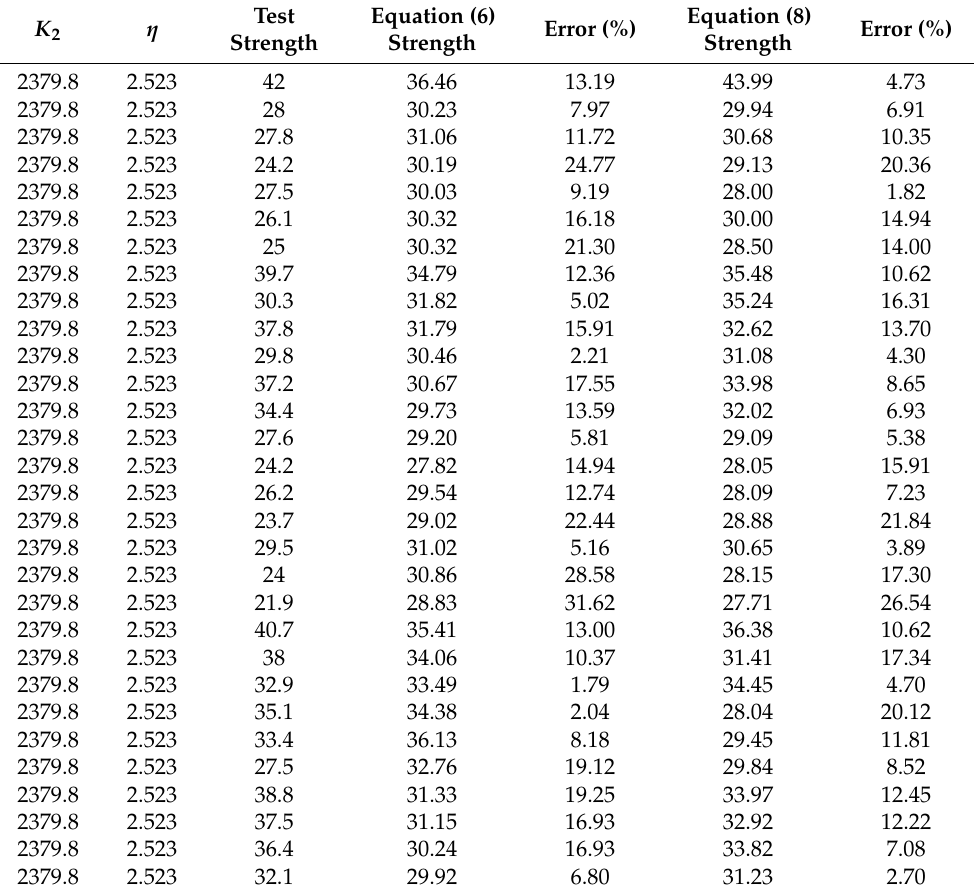
Table 6. Test constants and strength